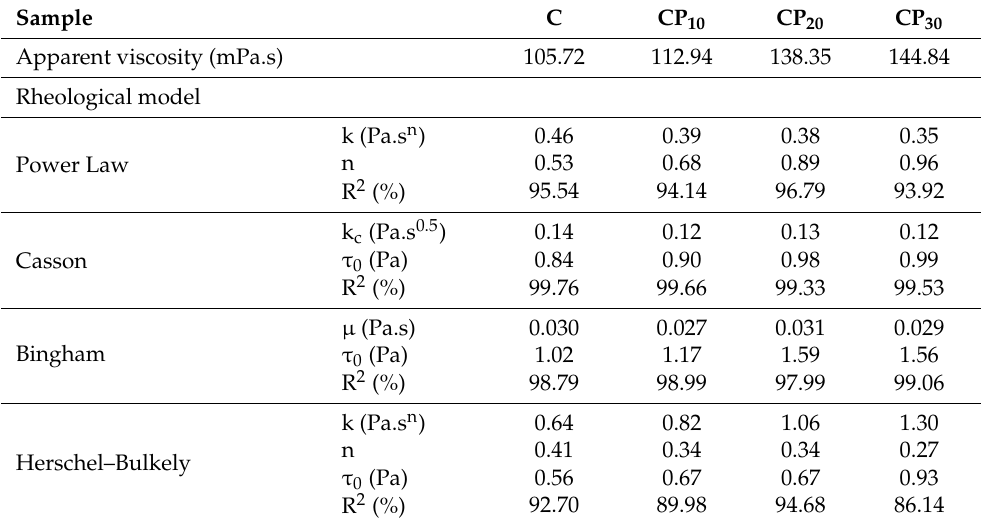
Table 2. Apparent viscosity and rheological parameters of different BSG dispersions (0.3%) at 20 ◦ C. Sample Apparent viscosity